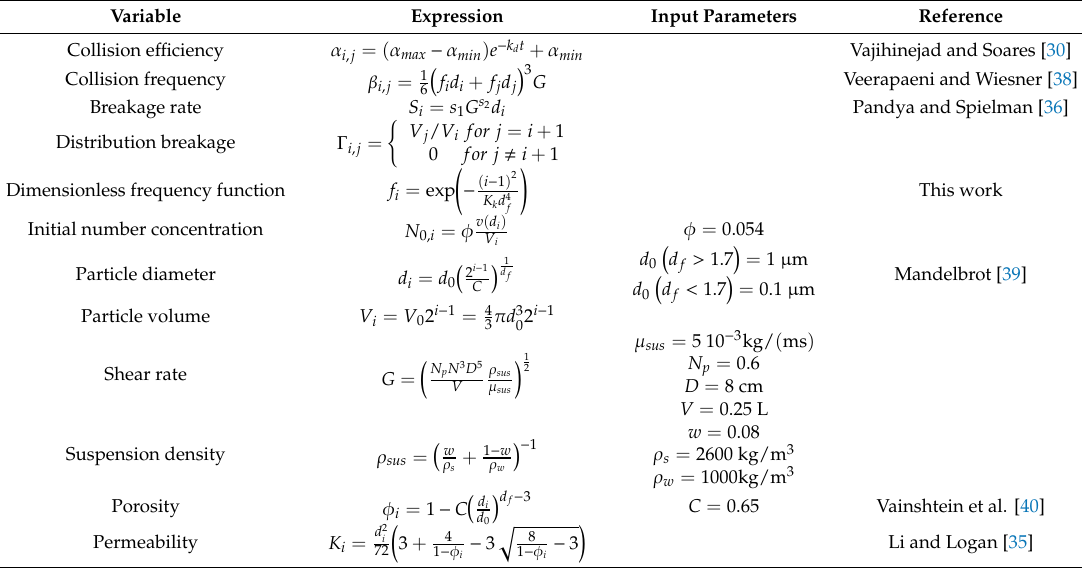
Table 1. Numeric expressions used for population balance models (PBM) Equation